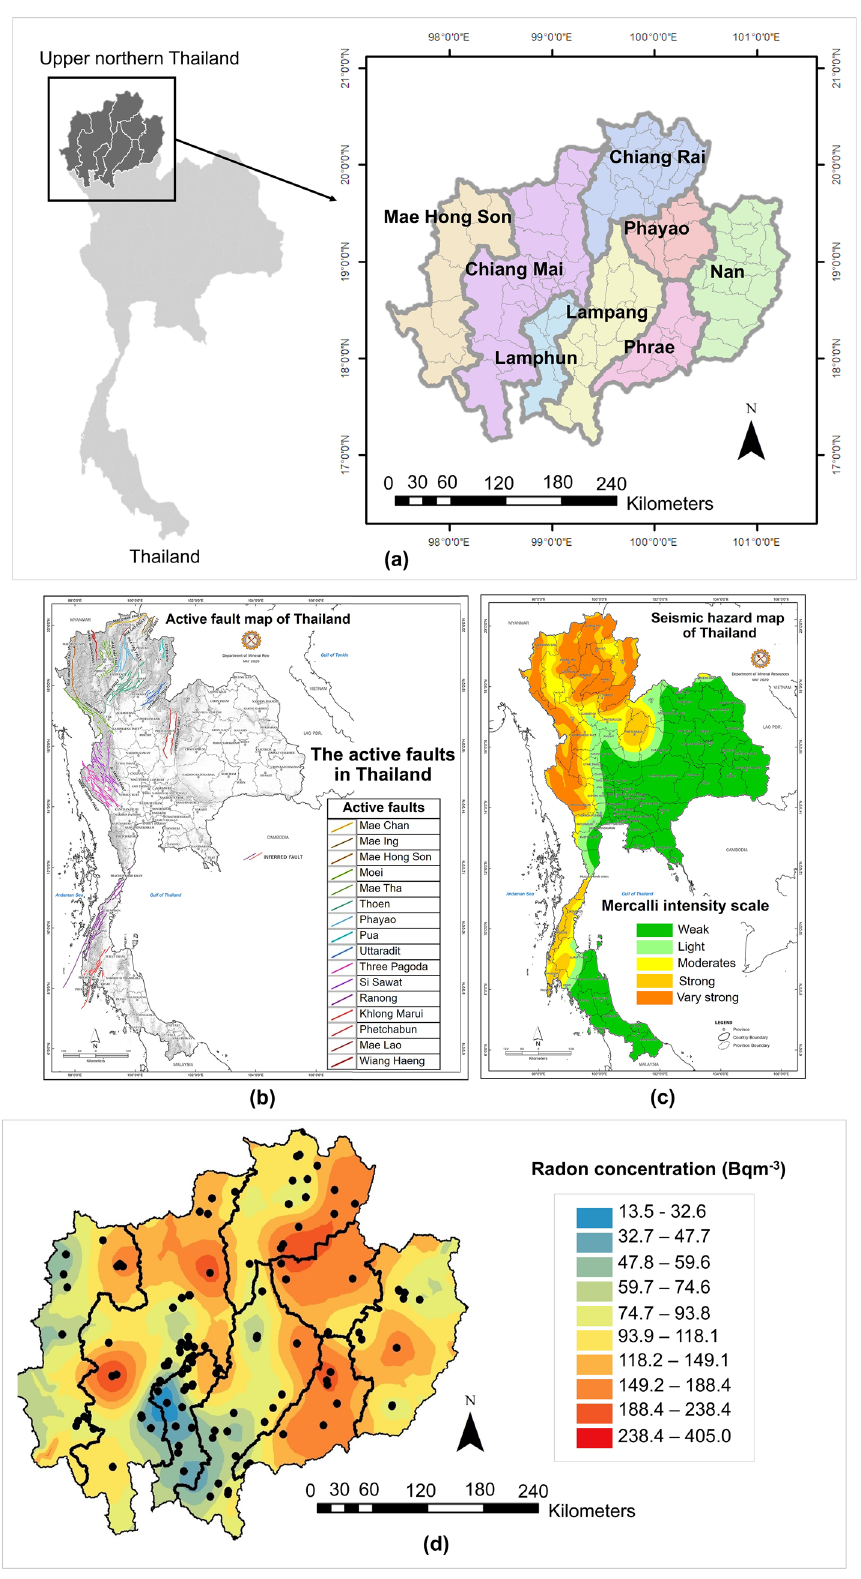
Figure 1. Study area, sample locations and distribution of indoor radon concentrations. ( a ) Study sites of eight provinces in upper northern Thailand, ( b ) Active fault zones in Thailand, ( c ) Seismic hazard map of Thailand, ( d ) Distribution of indoor radon concentration, with sampling points indicated in black dots using ArcMap software, Geostatistical wizard, Kriging method. Active fault zones in Thailand map and Seismic hazard map of Thailand obtained from the Department of Mineral Resources, Thailand (http:// webeng. dmr. go. th/ Show_ Detail. aspx? Detai lId=